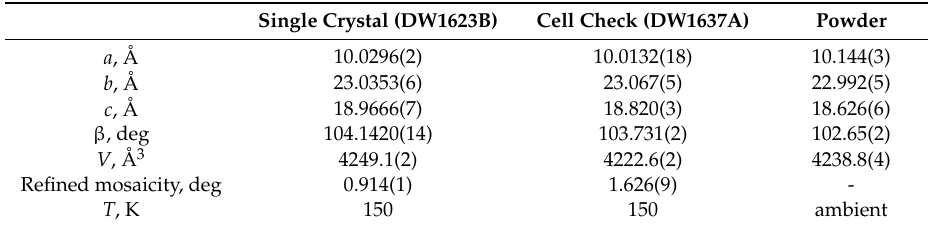
Table 7. Unit cell parameters of Fondaparinux determined for the single-crystal study, the cell check of a second batch, and the powder diffraction study. In all cases systematic absences indicate the space group is P 2 1 . s.u.’s are included in